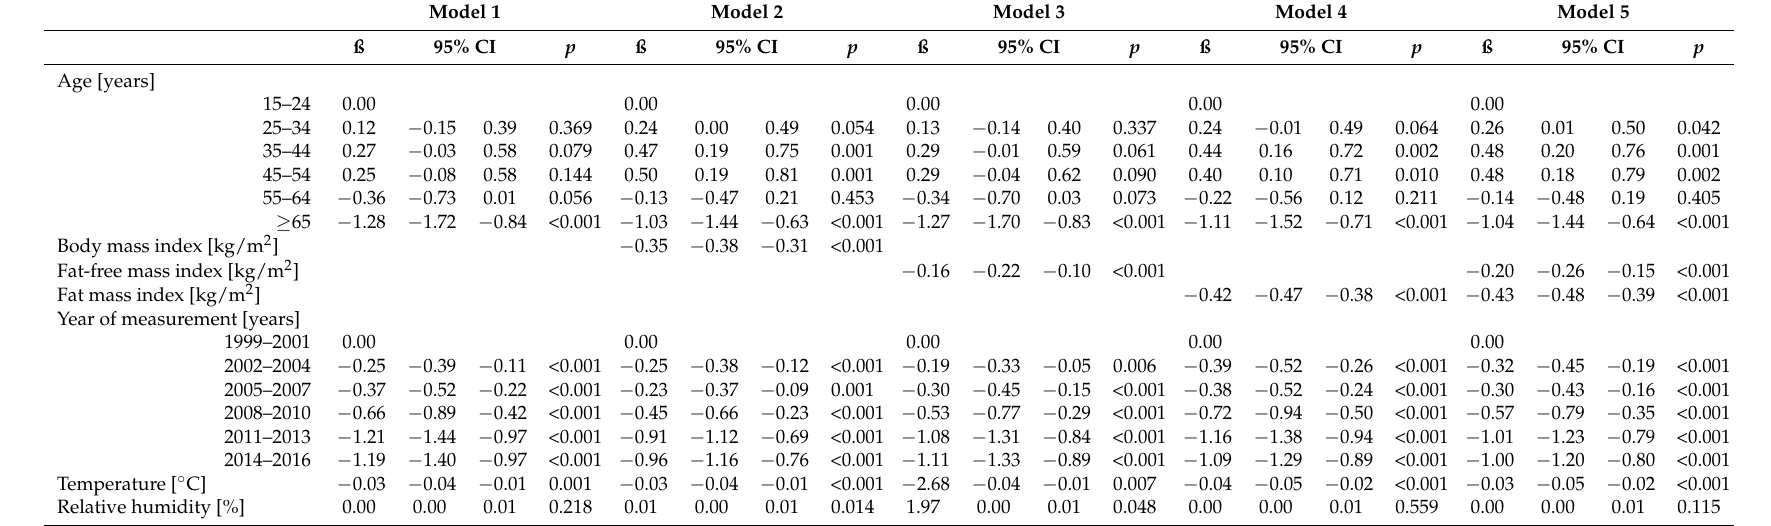
Table 3. Multivariate mixed linear regression to predict changes in running speed in men [509 participants, 2161